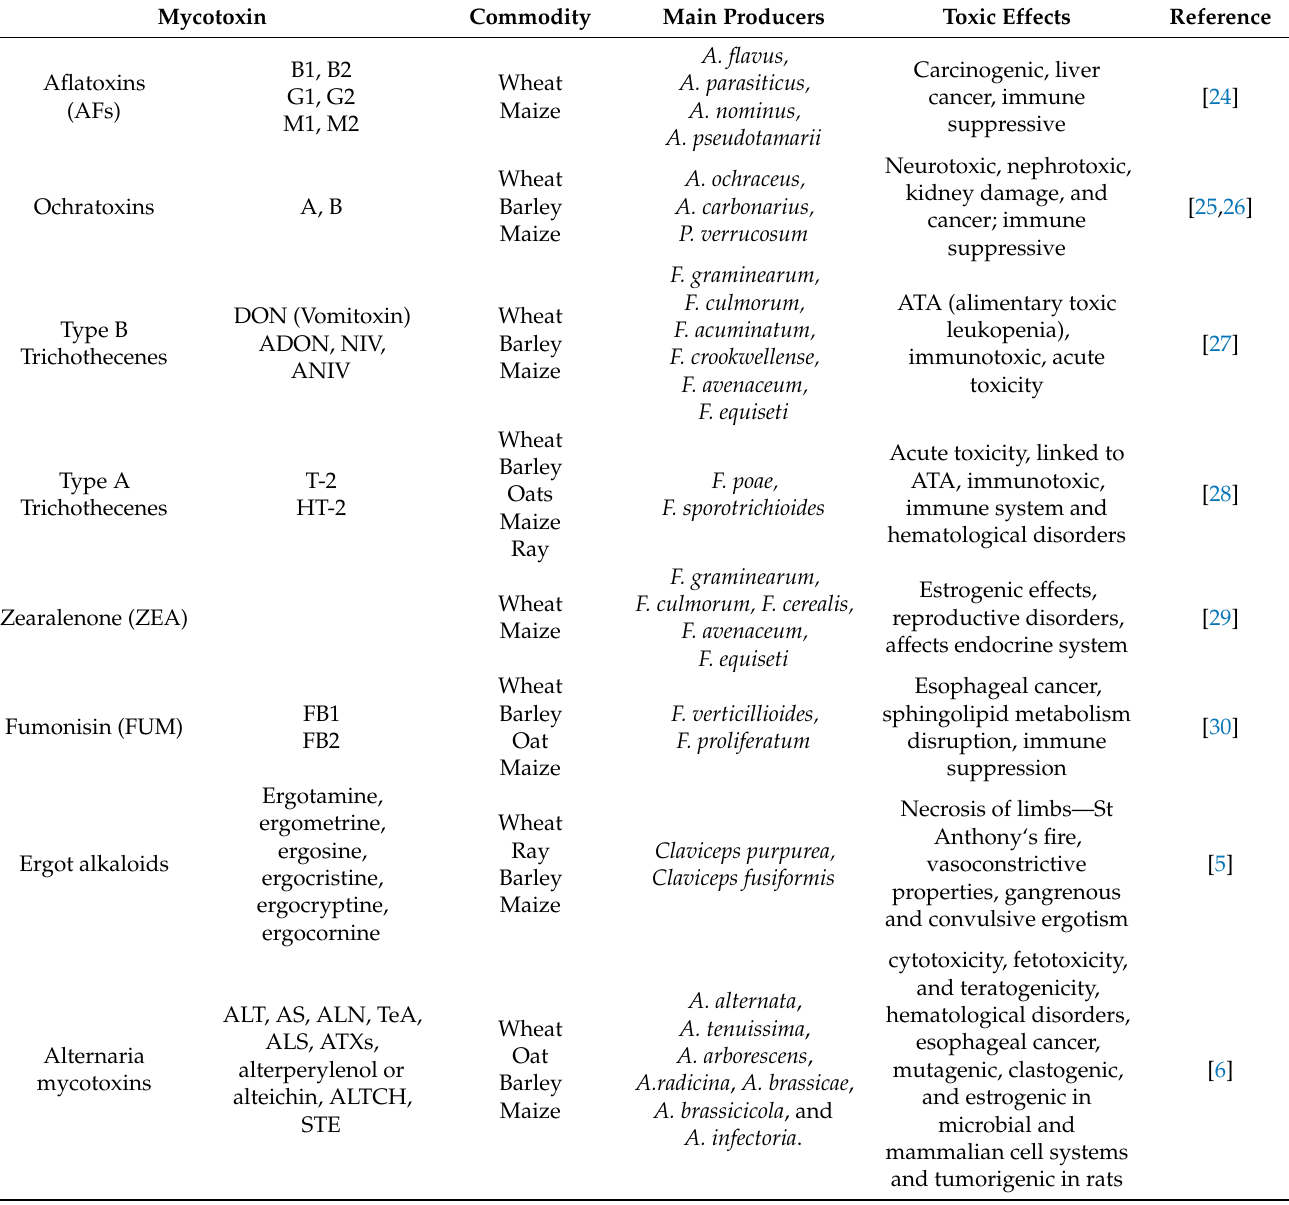
Table 1. Important mycotoxins, their occurrence, main producers, and toxic